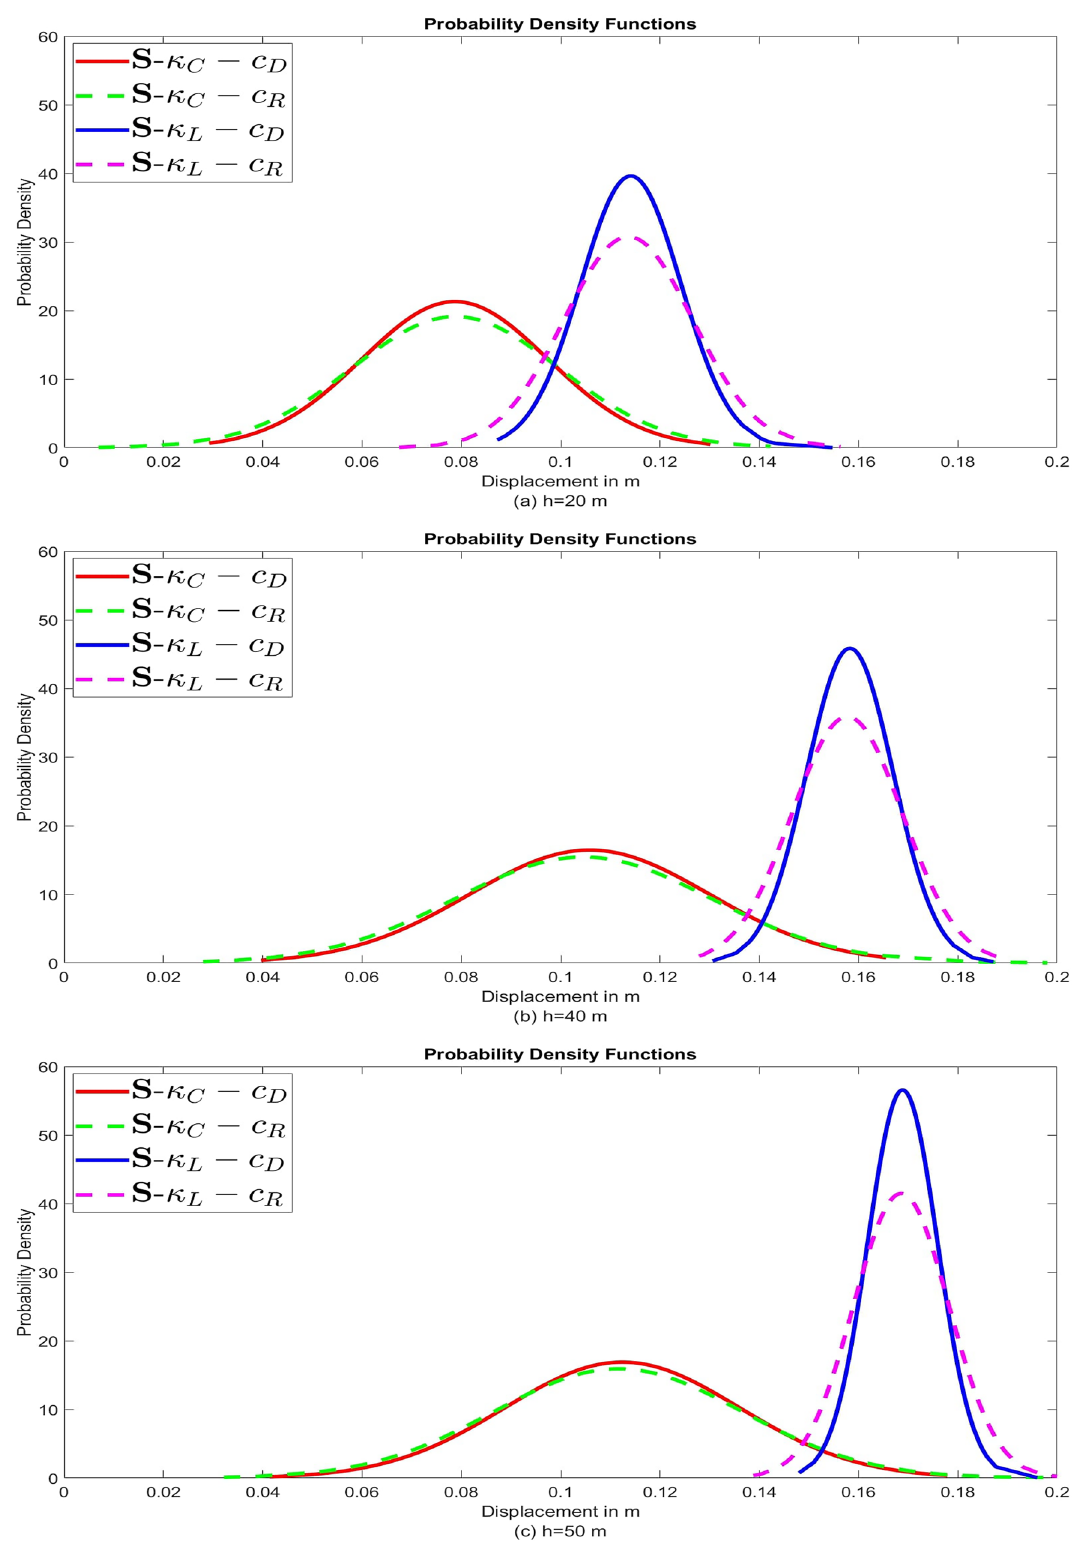
Fig. 8 PDFs of failure displacements of solid